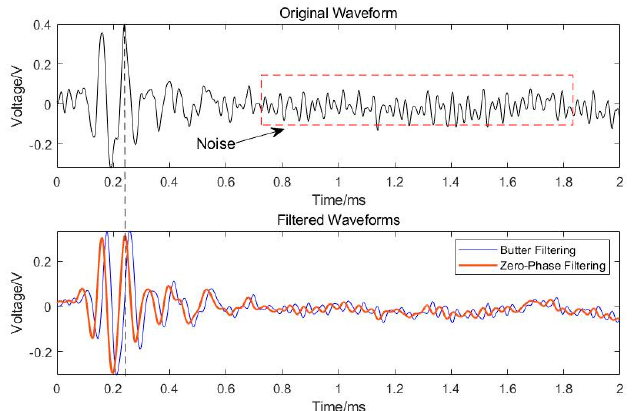
Figure 3. Signal filtering. The upper graph is the original signal, and the lower graph is the comparison of the filtering results of the Butterworth filter and the zero-phase filter on the original signal. The dotted line indicates the moment when the signal was triggered for